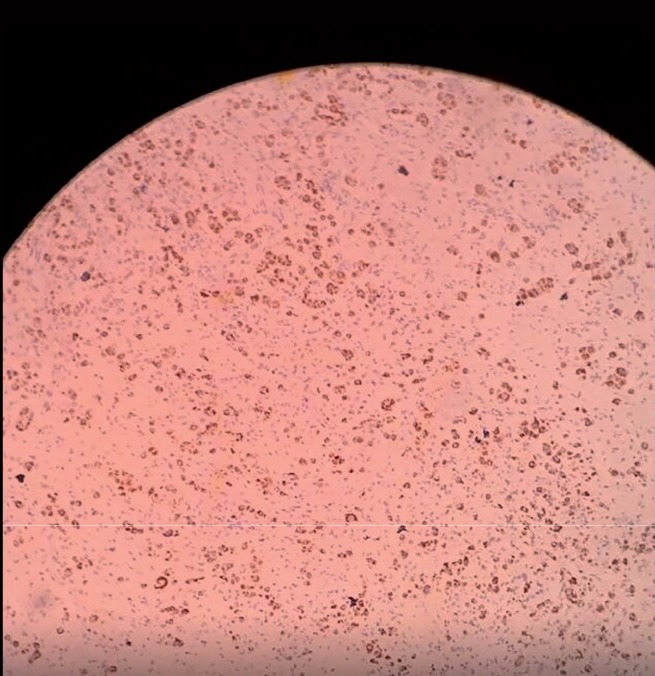
Melan-A antibody (4x).